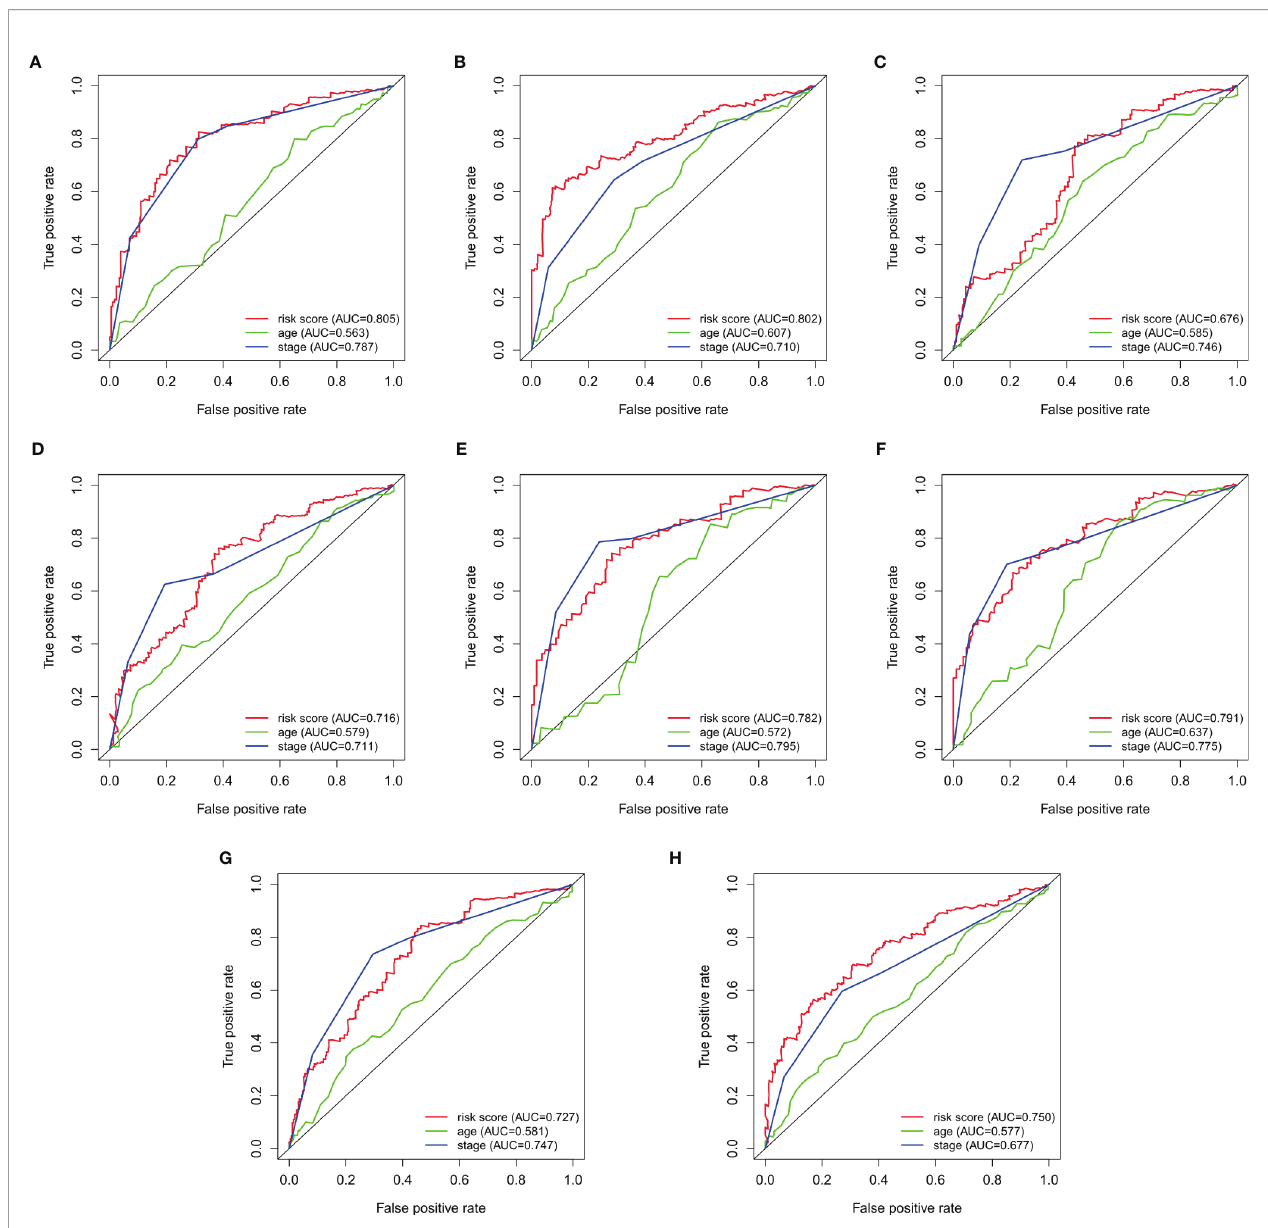
FIGURE 3 | Survival-dependent receiver operating characteristics (ROC) for predicting survival in the datasets. ROC for predicting the (A) 3-year, and (B) 5-year survival in the training dataset. ROC for the (C) 3-year, and (D) 5-year survival in the 1 st validation dataset. ROC for predicting the (E) 3-year, and (F) 5-year survival in the 2 nd dataset. ROC for predicting the (G) 3-year, and (H) 5-year survival in the 3 rd validation